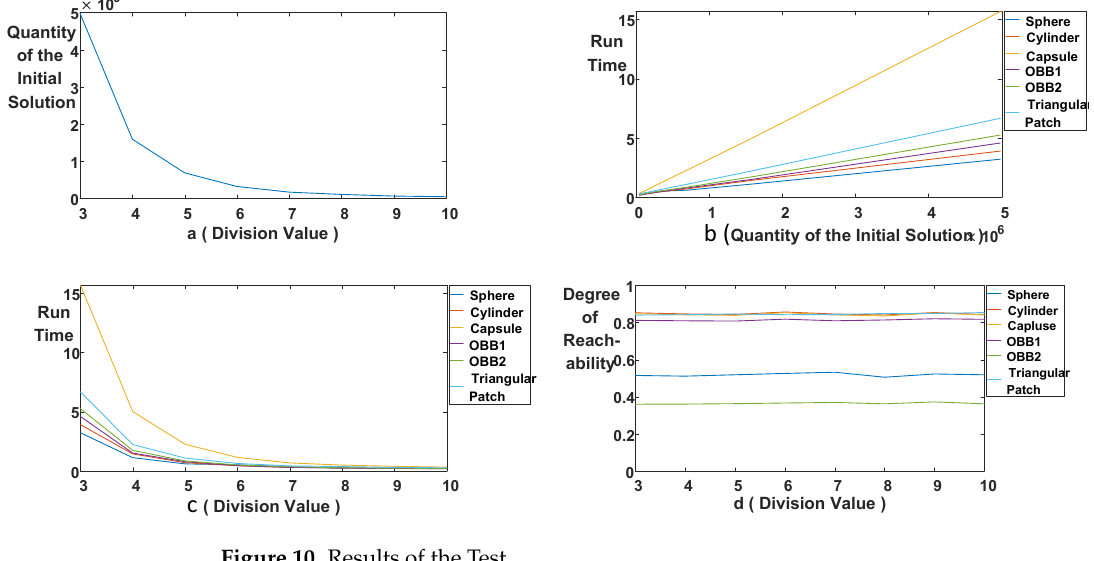
Figure 10. Results of the